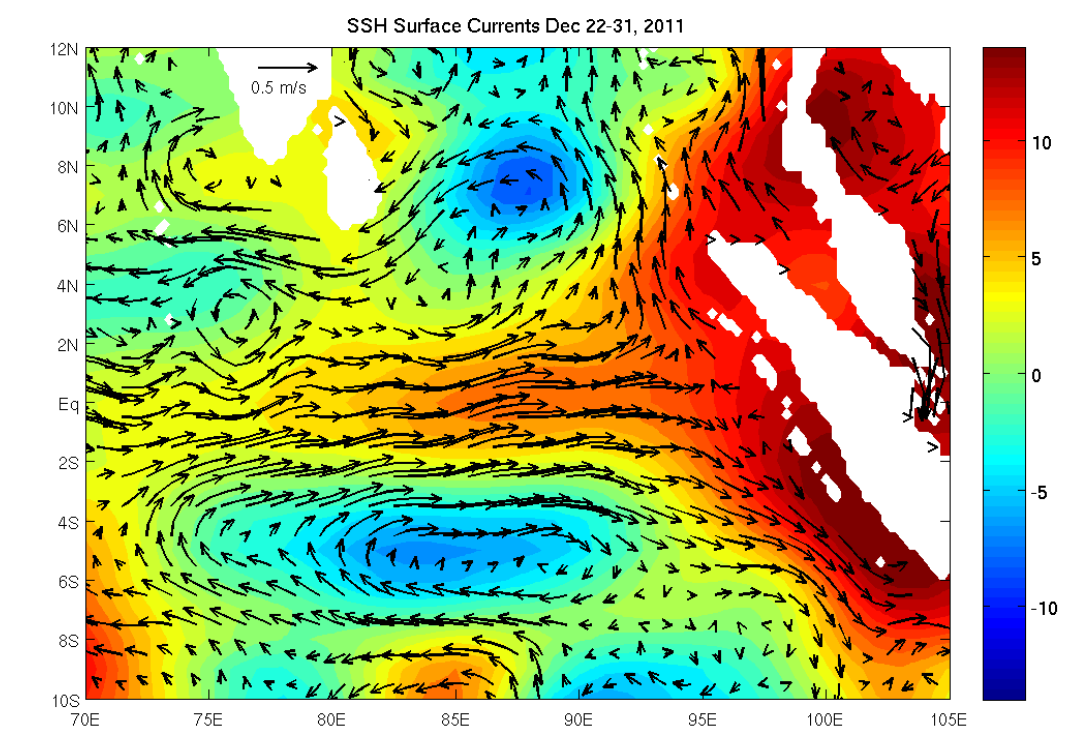
Figure 6. Average SSH anomaly (cm; shading) from altimetry and surface currents (m/s; arrows) from OSCAR during 22–31 December